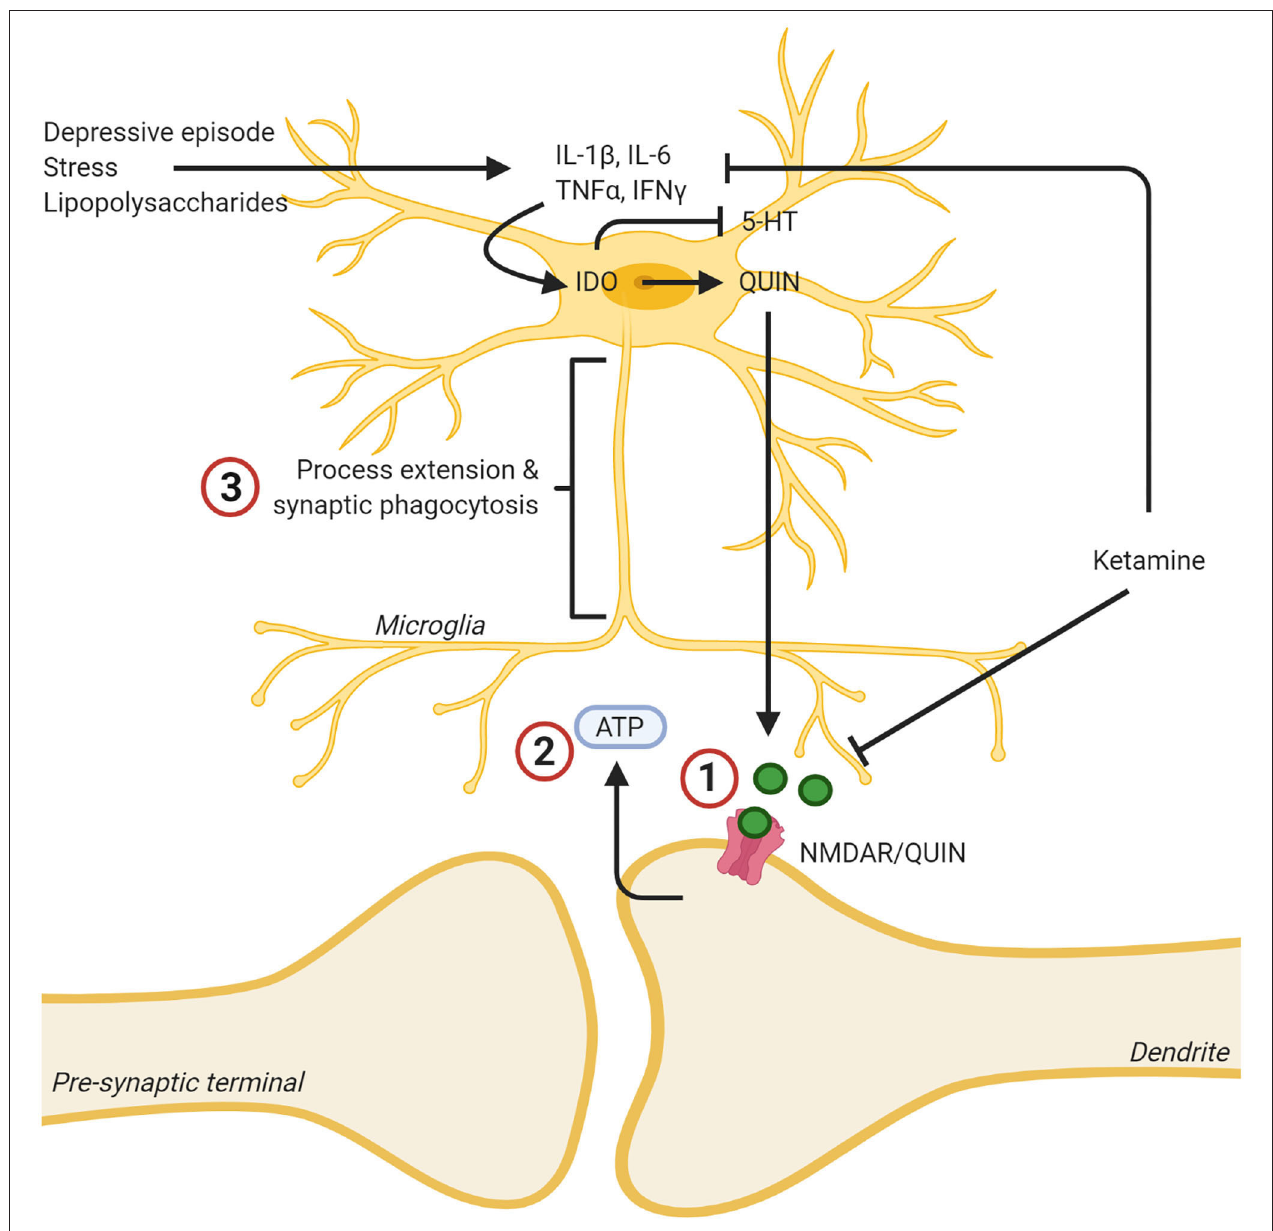
FIGURE 1 | Ketamine’s effects on the kynurenine pathway leads to lowered levels of neurotoxic quinolinic acid (QUIN) via inhibition of cytokine production, and lowered effects of QUIN/NMDA binding by blocking the NMDA receptor. (1) Ketamine binding blocks the NMDA receptor, reducing the neurotoxic effects of QUIN released from microglia. (2) This decreased neurotoxicity decreases ATP release from the synapse. (3) As a result, the microglia no longer extend toward this “find me” signal and the inflammatory reaction is dampened, and the microglia assumes a less reactive state. In addition, ketamine was found to mitigate the reaction of microglia to inflammatory stimuli such as stress or LPS and decreased the production of proinflammatory cytokines. Created with BioRender.com.